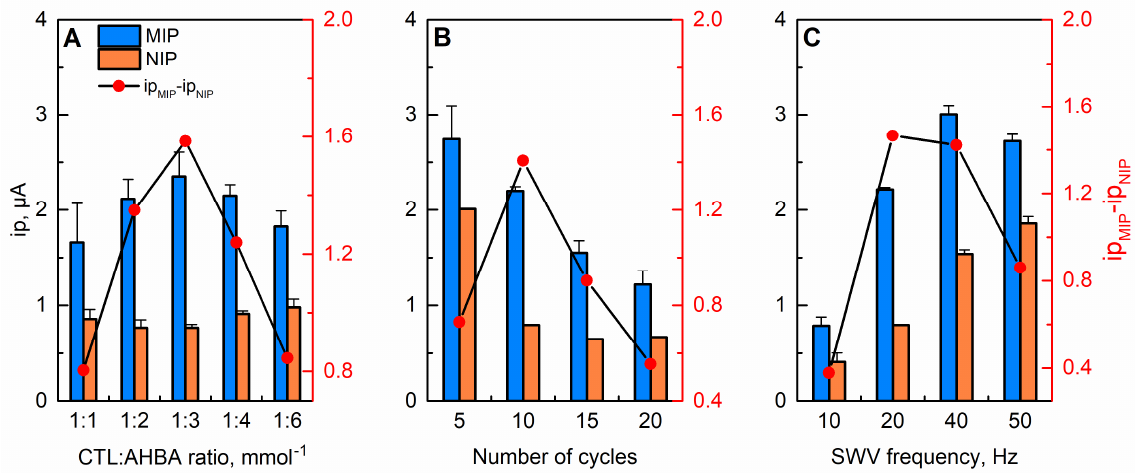
Figure 5. Effects of ( A ) molar ratio of CTL to AHBA, ( B ) number of polymerization scan cycles, and ( C ) frequency applied during SWV on sensing responses of MIP and NIP sensors toward 10 μ mol L − 1